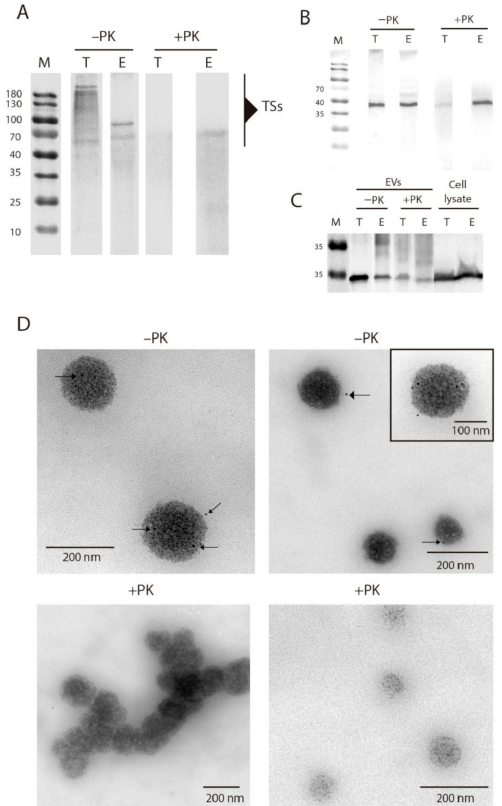
Figure 4. Location of TS proteins on the surface of EVs of T. cruzi. ( A ) Western blot of EVs of E and EVs of TCT treated/untreated (+PK/ − PK, respectively) with proteinase K and incubated with anti-TS antibodies. All lanes were loaded with an equal amount of protein (30 µ g). ( B ) Western blot of EVs of E and EVs of TCT treated/untreated (+PK/ − PK, respectively) with proteinase K and incubated with anti-cruzipain antibodies. All lanes were loaded with an equal amount of protein (30 µ g). ( C ) Western blot of EVs of E and EVs of TCT treated/untreated with proteinase K and whole lysates of TCT and E incubated with anti-calmodulin antibodies. All lanes were loaded with equal amount of protein (30 µ g). ( D ) Immunogold labeling of TS proteins in EVs of TCT treated/untreated with proteinase K. Black arrows indicate the gold particles and thus TS